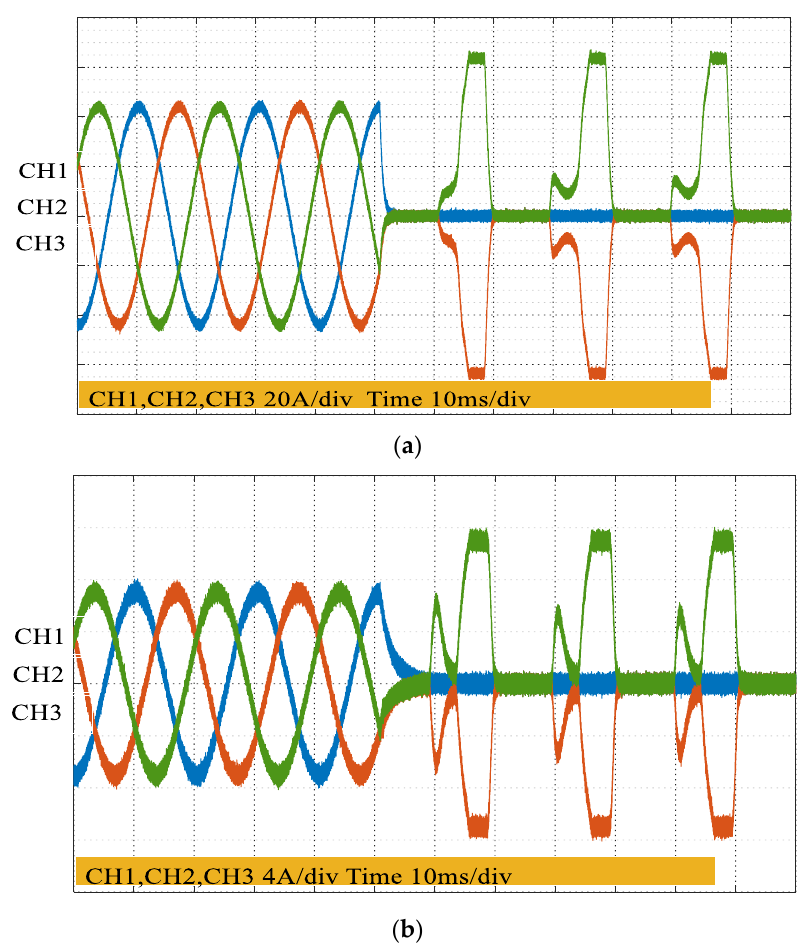
Figure 6. S1 and S2 open-circuit faults: ( a ) output current is 44 A, ( b ) output current is 8.8 A.